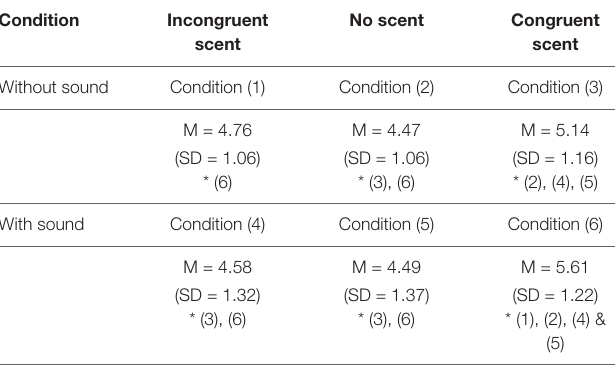
TABLE 2 | Descriptive statistics “Sensory Experience” across all six experimental